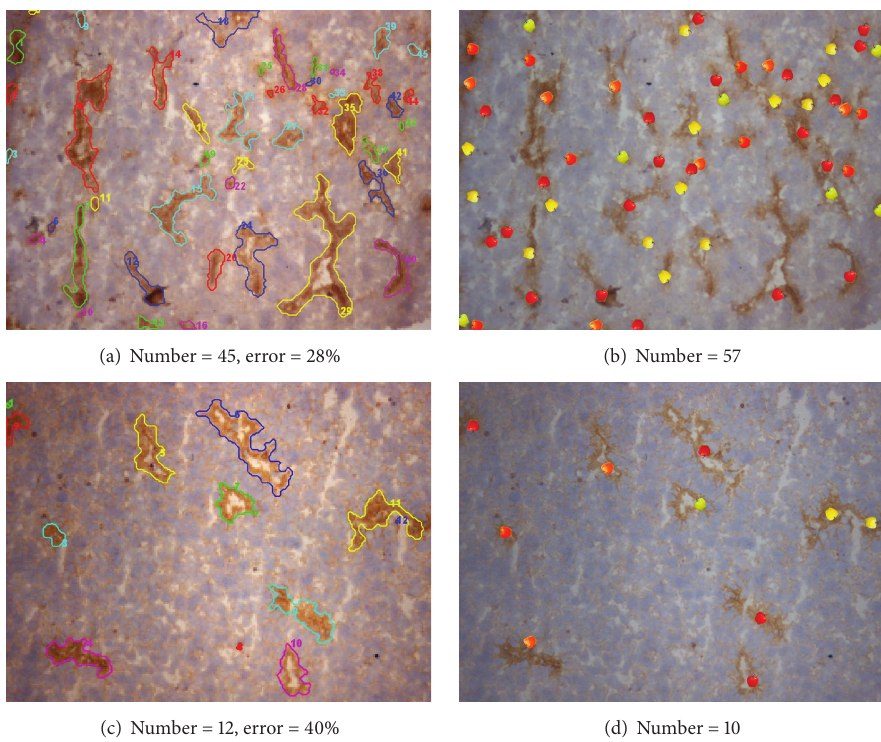
Figure 11: Calculation results. ((a), (c)) The boundaries are generated by our algorithm; ((b), (d)) those in apple dots are from the observer.